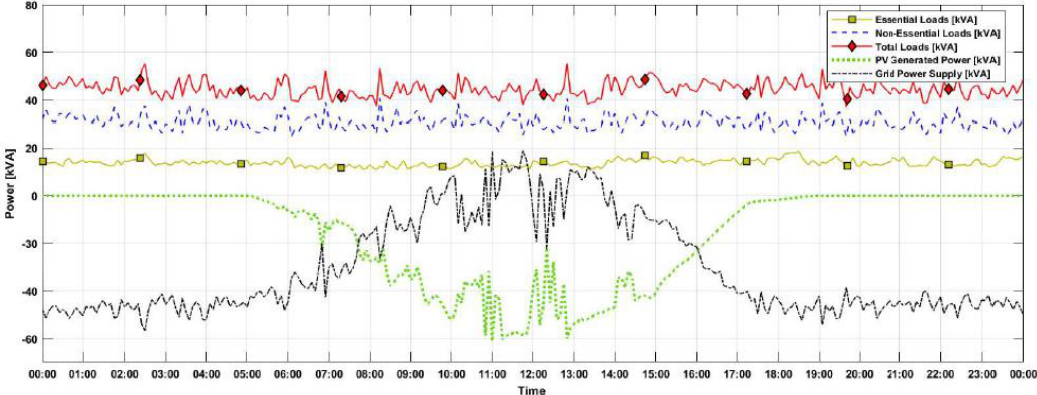
Figure 11. The behavior of MCAST micro-grid without BESS on a typical Sunday.